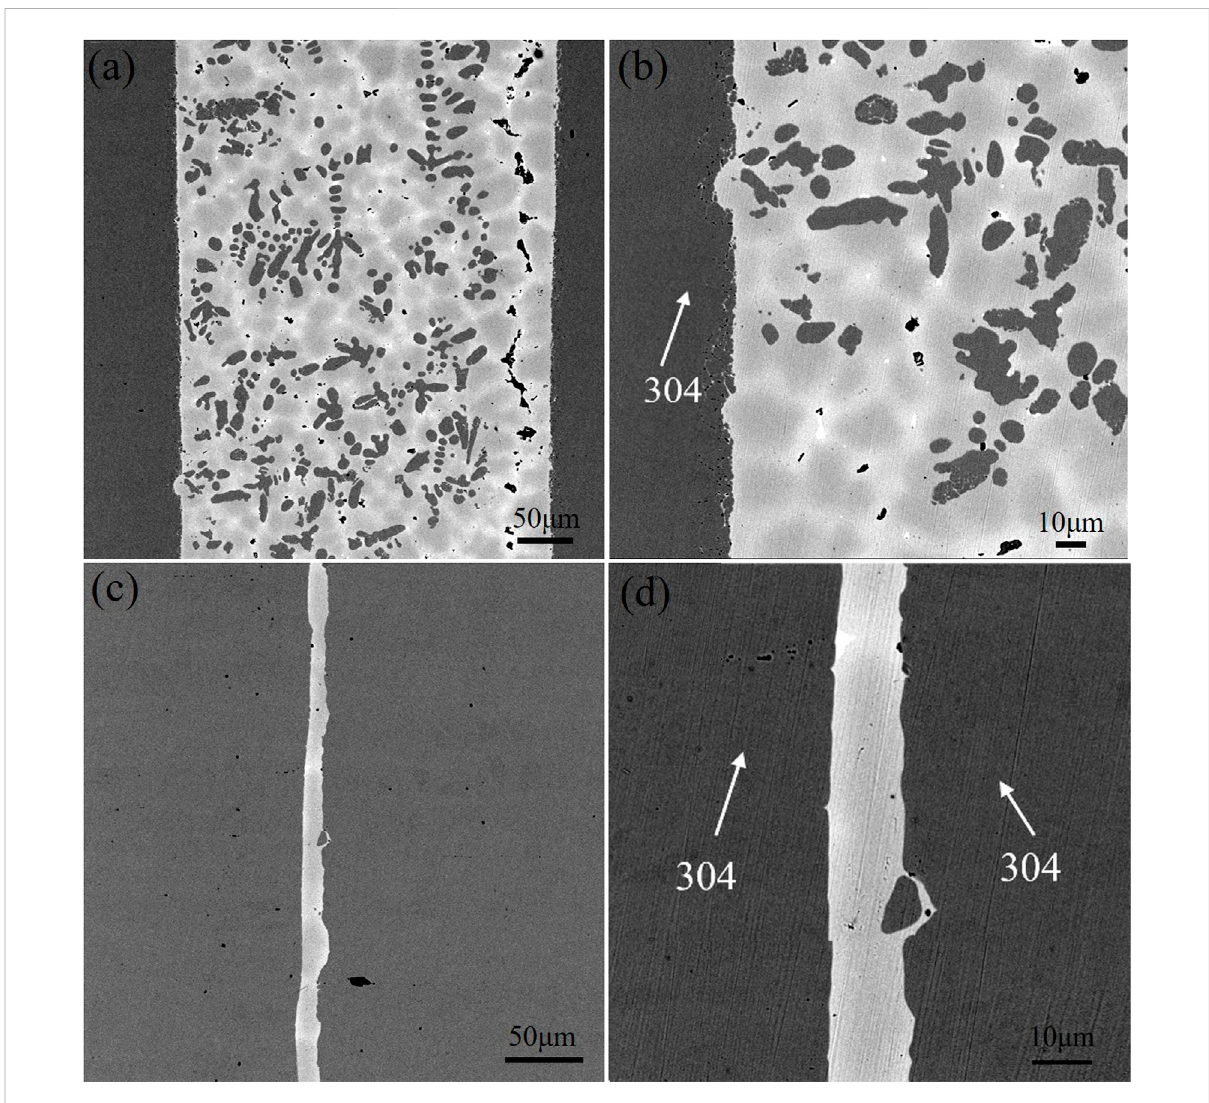
FIGURE 8 Microstructure of brazed joints with two brazing alloys (A) (B) brazed joint with alloy obtained by melting the circuit board and (C) (D) alloy obtained by pure